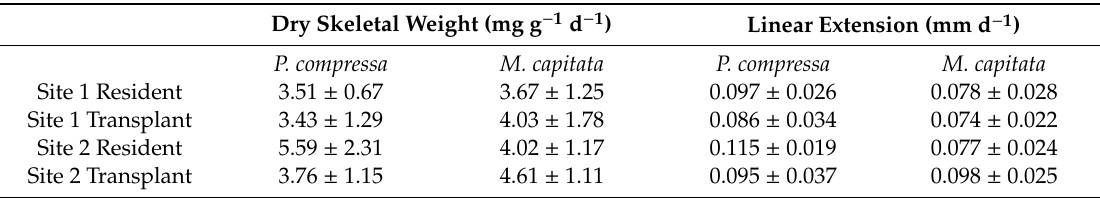
Table 2. Mean linear extension and dry skeletal weight ± SD for resident and transplant M. capitata and P. compressa coral nubbins at each site with outliers included.